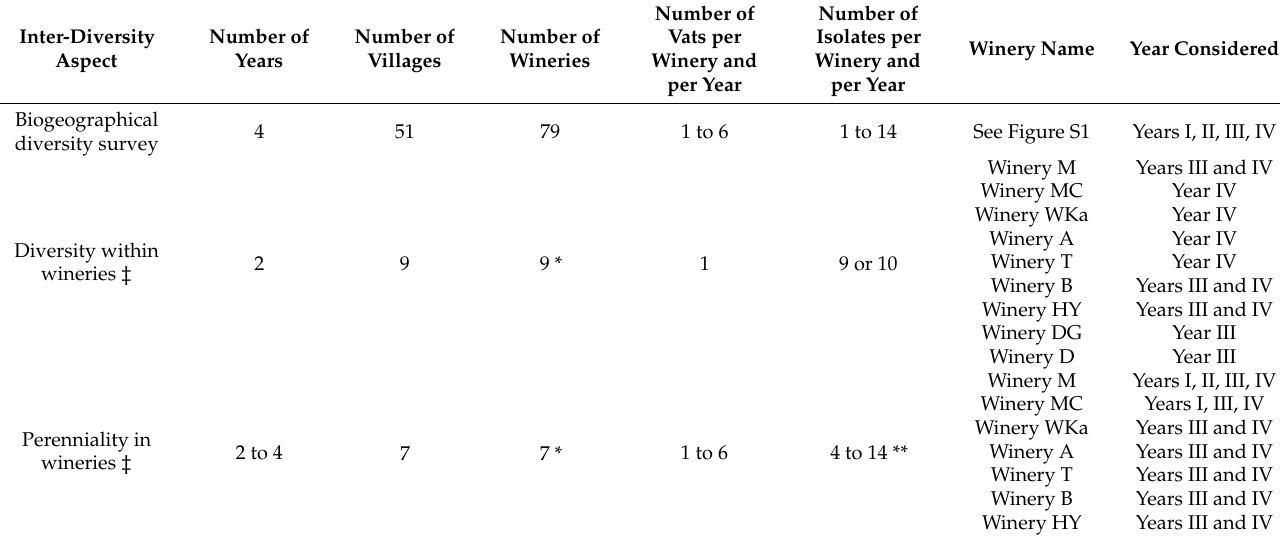
Table 1. Various diversity aspects studied within the Saccharomyces cerevisiae Lebanese flora, with interdelta fingerprinting. Inter-Diversity Number of Number of Aspect Years